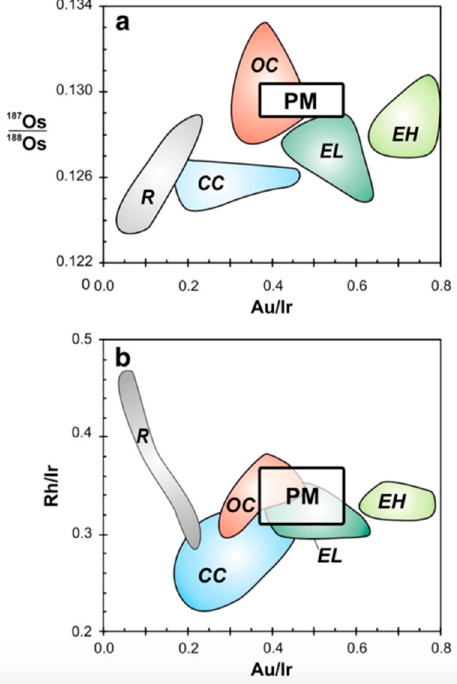
Figure 2. Ratio diagrams of Au/Ir vs. 187 Os/ 188 Os and Au/Ir vs. Rh/Ir constructed for the PM and different chondrite classes and groups. The HSE composition determined for the PM model is similar to those of ordinary (OC) and enstatite (EL) chondrites, but differs from the compositions of carbonaceous (CC) and Rumuruti (R) chondrites. Reprinted with permission from [5].